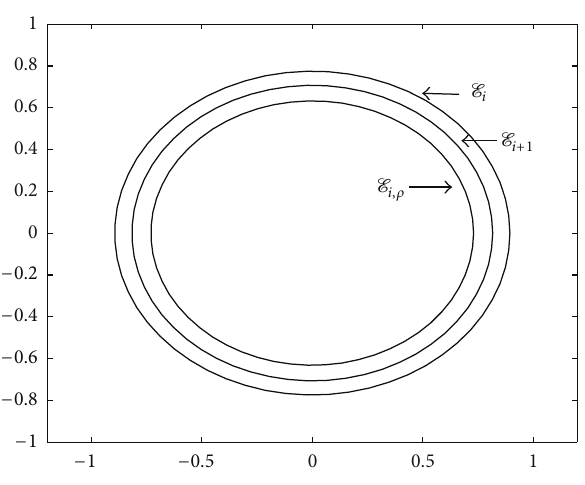
Figure 1: Relationship between E 𝑖 , E 𝑖,𝜌 , and E 𝑖+1 .